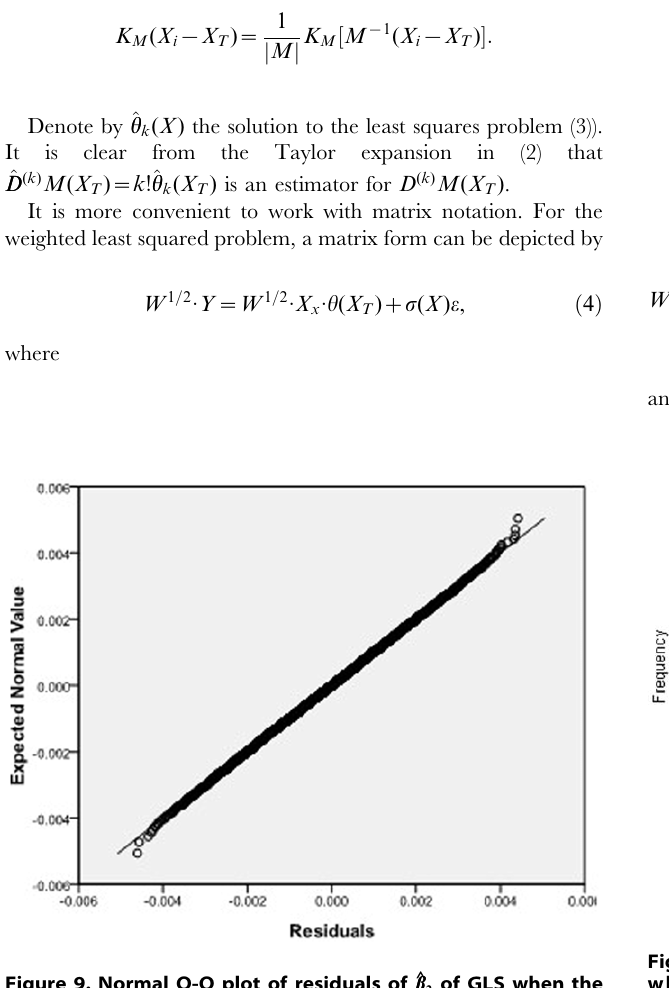
Figure 9. Normal Q-Q plot of residuals of ^ bb 2 of GLS when the variance function of the error term is s 2 ( x 1 , x 2 ) ~ exp ( { ( x 1 z x 2 )) .